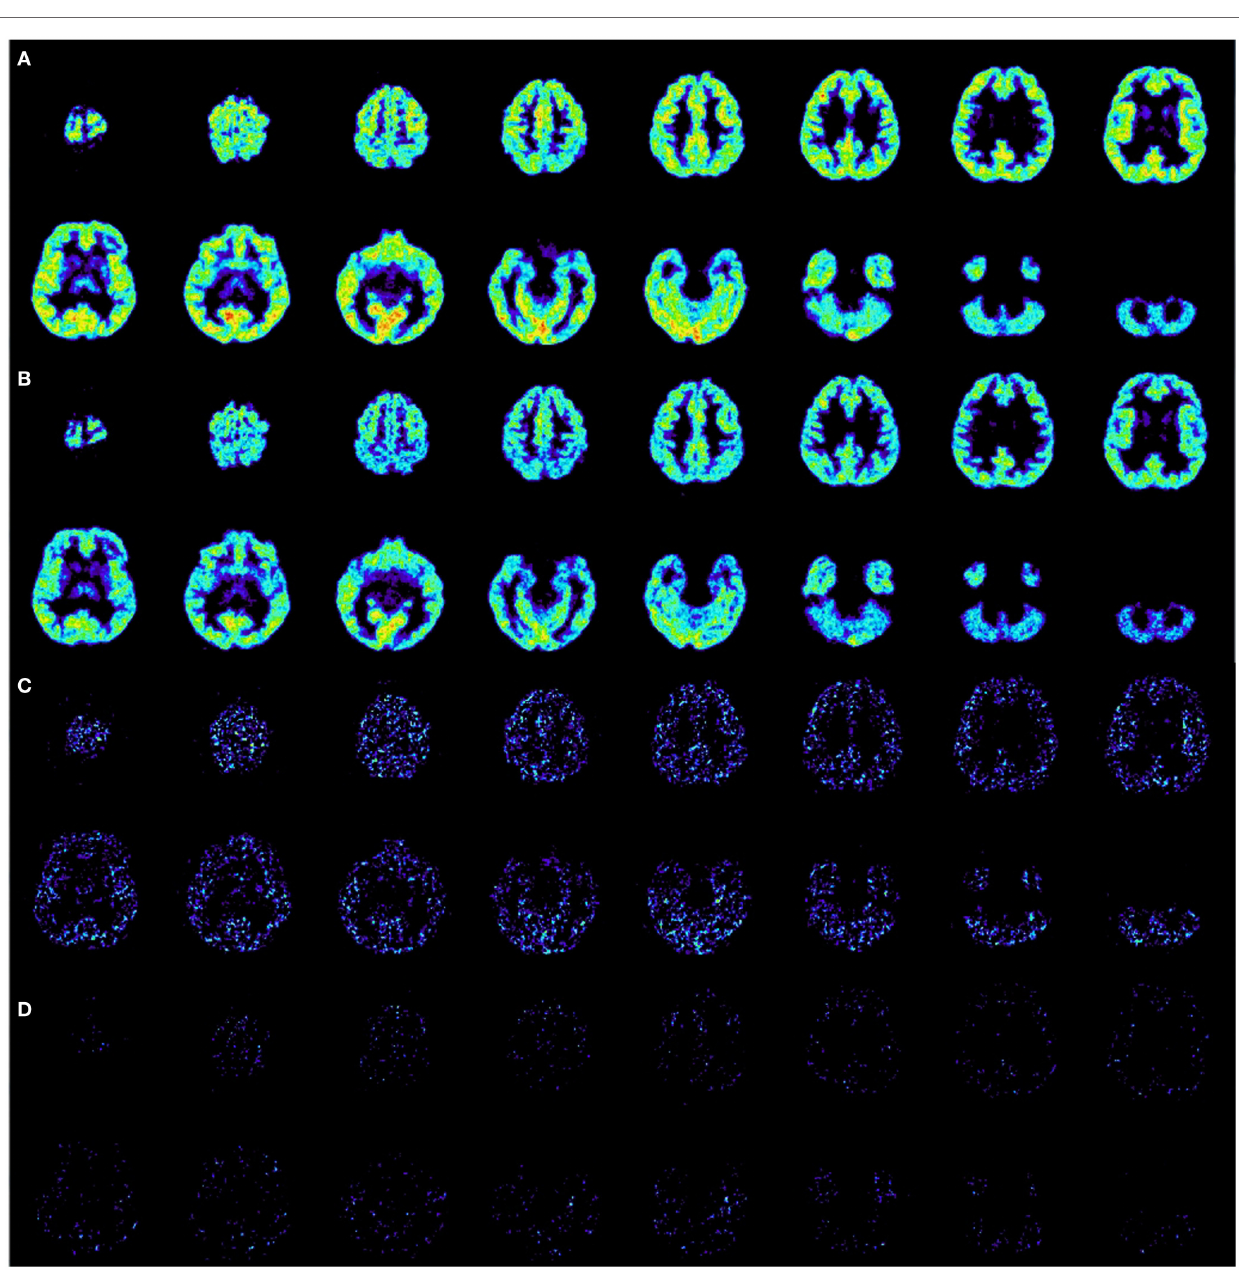
FiGuRe 5 | ethyl 8-fluoro-5-[(11)C]methyl-6-oxo-4H-imidazo[1,5-a][1,4] benzodiazepine-3-carboxylate positron emission tomography ( = 11C-flumazenil Pet) . (a) Scan before first application of basiliximab, normalized to injected activity of 580 MBq with an acquisition time from 20 to 40 min after injection. (B) Scan after sixth application of basiliximab, normalized